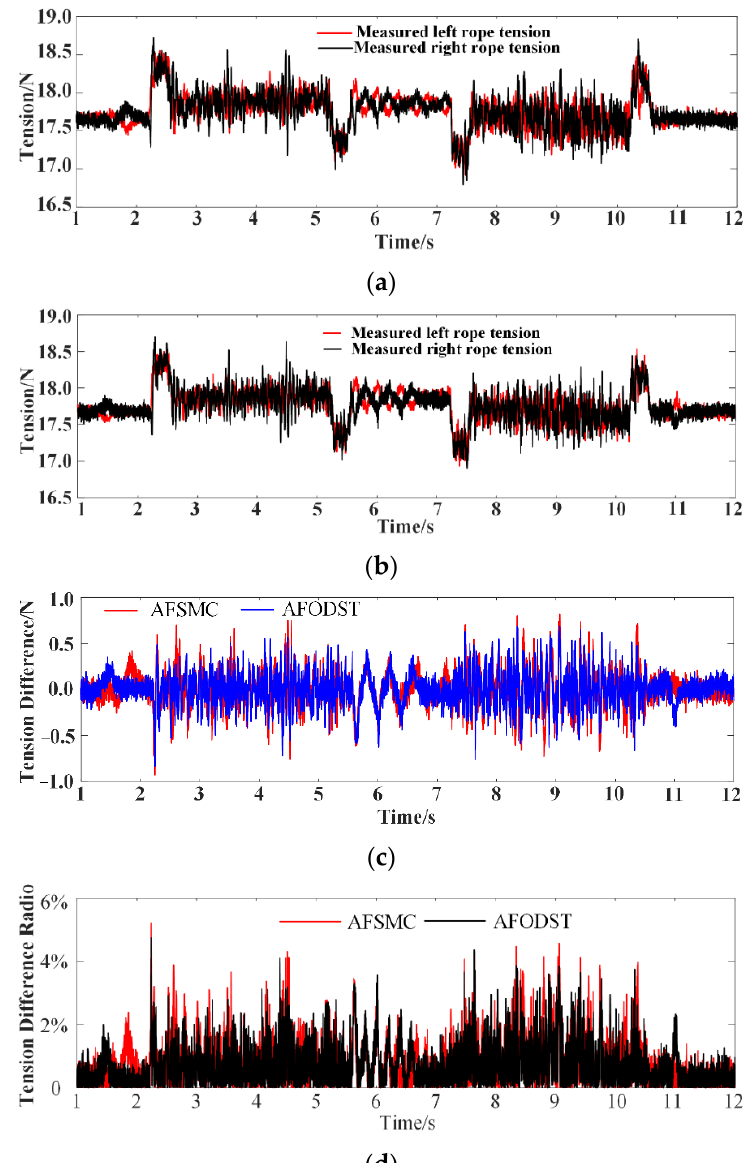
Figure 7. Measured rope tension and tension difference under normal condition: ( a ) Rope tension with AFSMC; ( b ) Rope tension with AFODST; ( c ) Tension difference; ( d ) Ratio of the tension difference to the average tension.